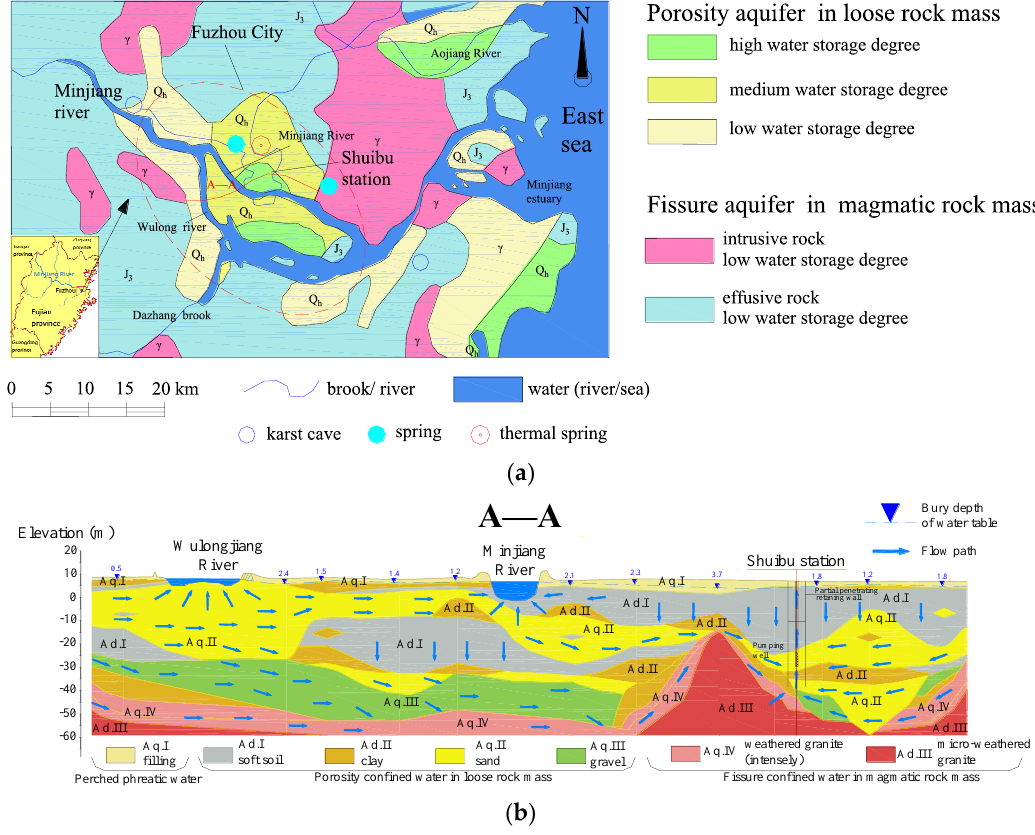
Figure 10. Hydrogeological conditions of the area: ( a ) Hydrogeological map of Fuzhou basin and coastal plain; ( b ) hydrogeological profile of the metro line.